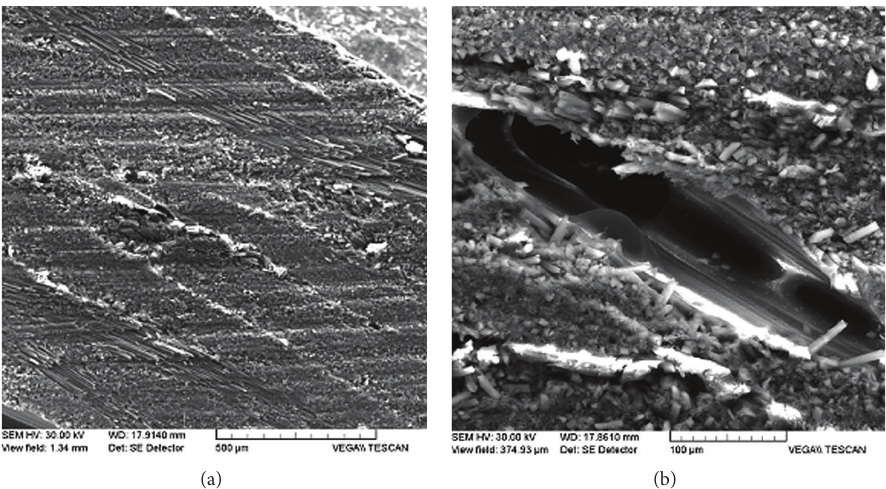
Figure 8: (a) The entire thickness cross-section of a sample manufactured at 30 psi. (b) Void also formed at 30 psi sample.